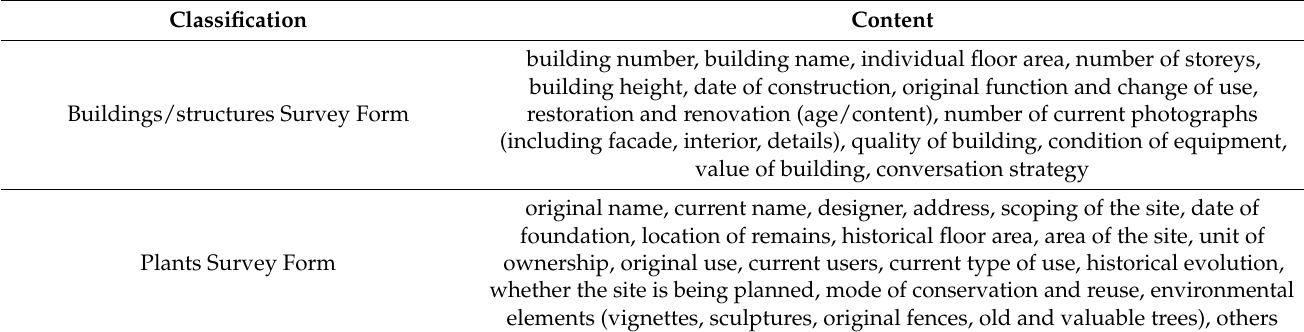
Table 1. Synopsis of the Tianjin Industrial Heritage Survey